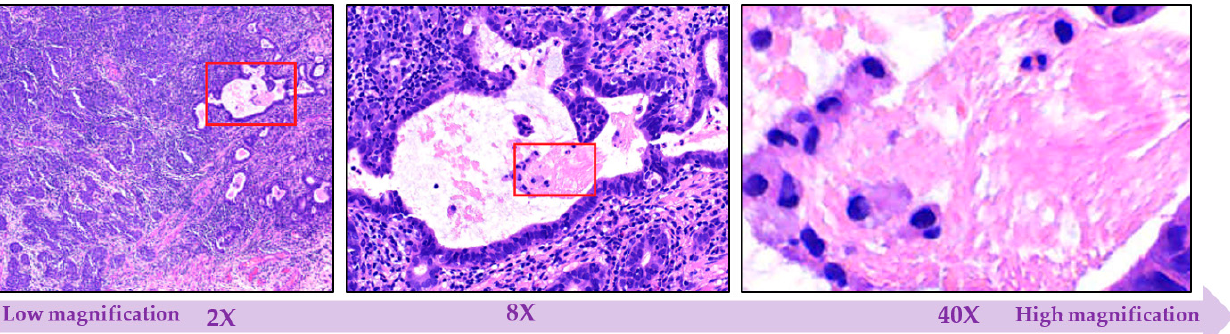
Figure 5. Illustrative figure showing the different levels of magnification (starting from 2 × up to more than 40 × ) that might be applied on histopathological images.